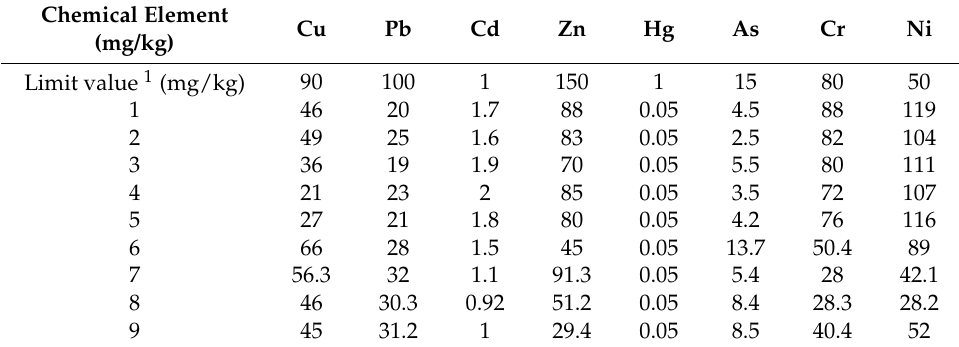
Table 3. Results of chemical analyses of heavy metal content in soil samples collected in the surroundings of Gacko coal